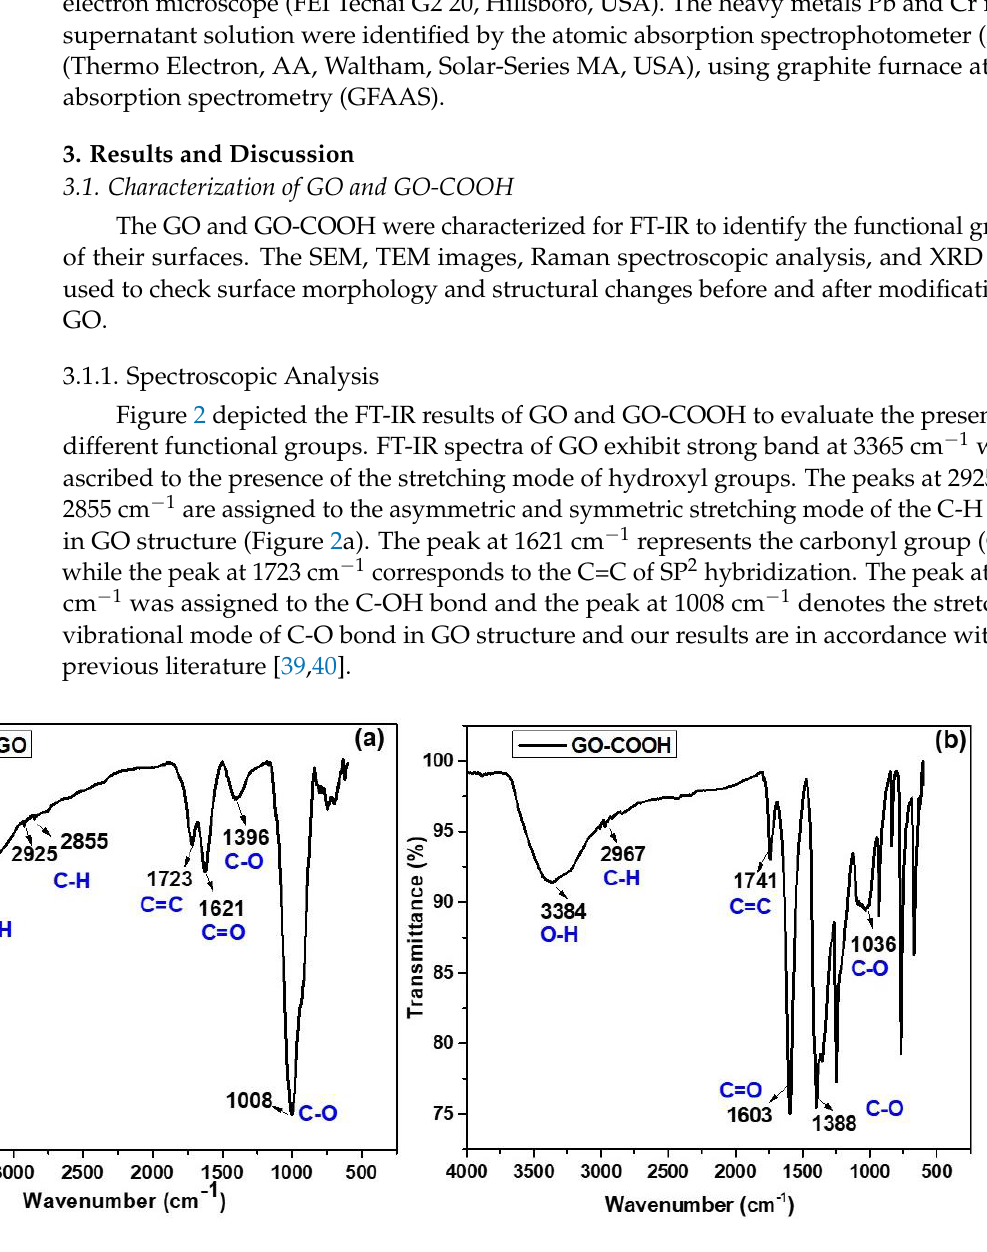
Figure 2. FTIR spectrum of ( a ) GO and ( b ) GO-COOH.